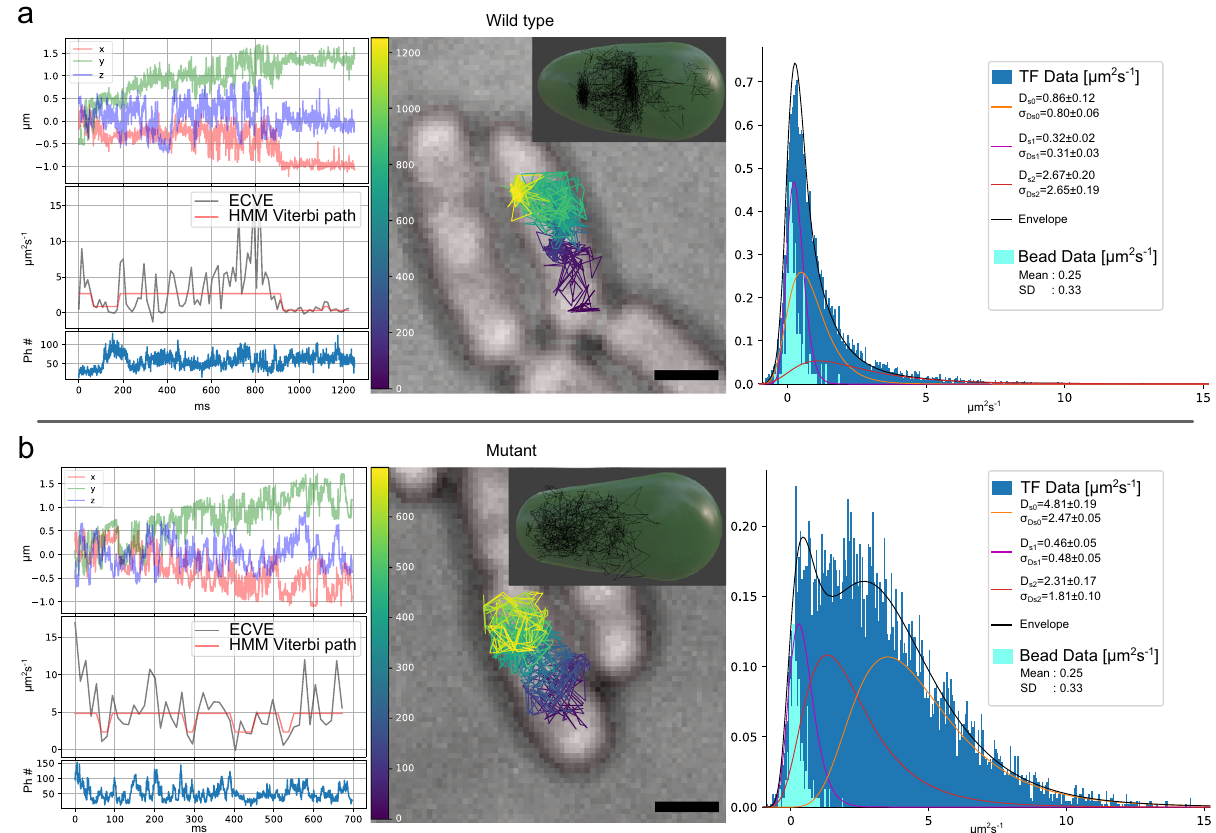
Fig. 4 | Tracking WT and mutant TF in E. coli cells. After the microscope cali- bration, we conducted two experiments on the same day: one experiment for the wild-type TF where 432 trajectories were acquired from 174 cells, and a second experiment forthe mutant TF, where 721 trajectorieswereacquired from 177cells. For each sample type, wild-type a and mutant b , an example trajectory (left) are showntogetherwiththedistributionoftheaccumulateddiffusionhistogramsover all measured trajectories of each type (right side). For each horizontal, the center image is the wide fi eld cell image (black bar 1 μ m) with estimated trajectory color- coded over time, and the inset is the 3D trajectory with a cell membrane repre- sentation based on the wide fi eld image. The left plots, for the same trajectory shown in the center image, are from the top; position estimation, point-wise